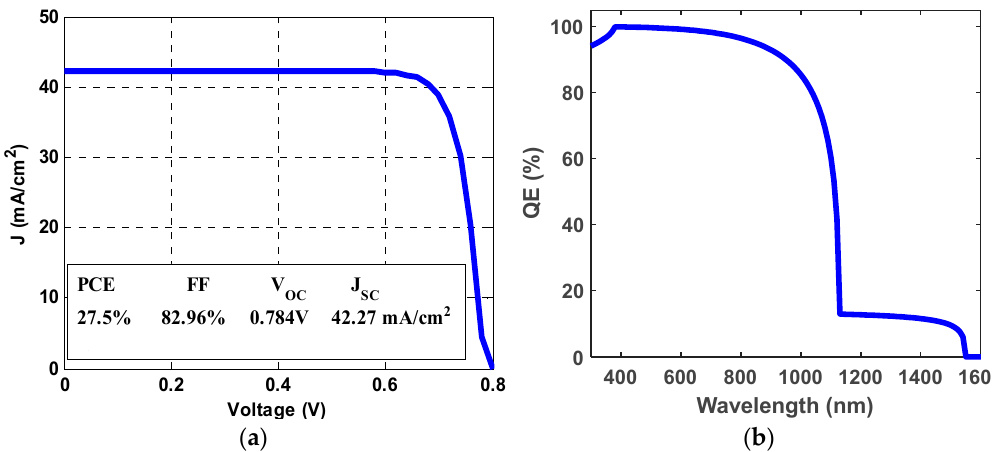
Figure 4. Effect of CIGS film thickness for the CIGS-GeTe absorber: ( a ) PCE, ( b ) FF, ( c ) V OC , and ( d ) J SC .